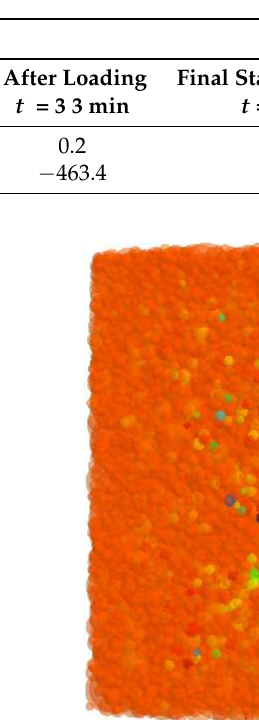
Table 3. Evolution of maximum and minimum values of particle hydrostatic stresses [MPa] during the hot pressing process.